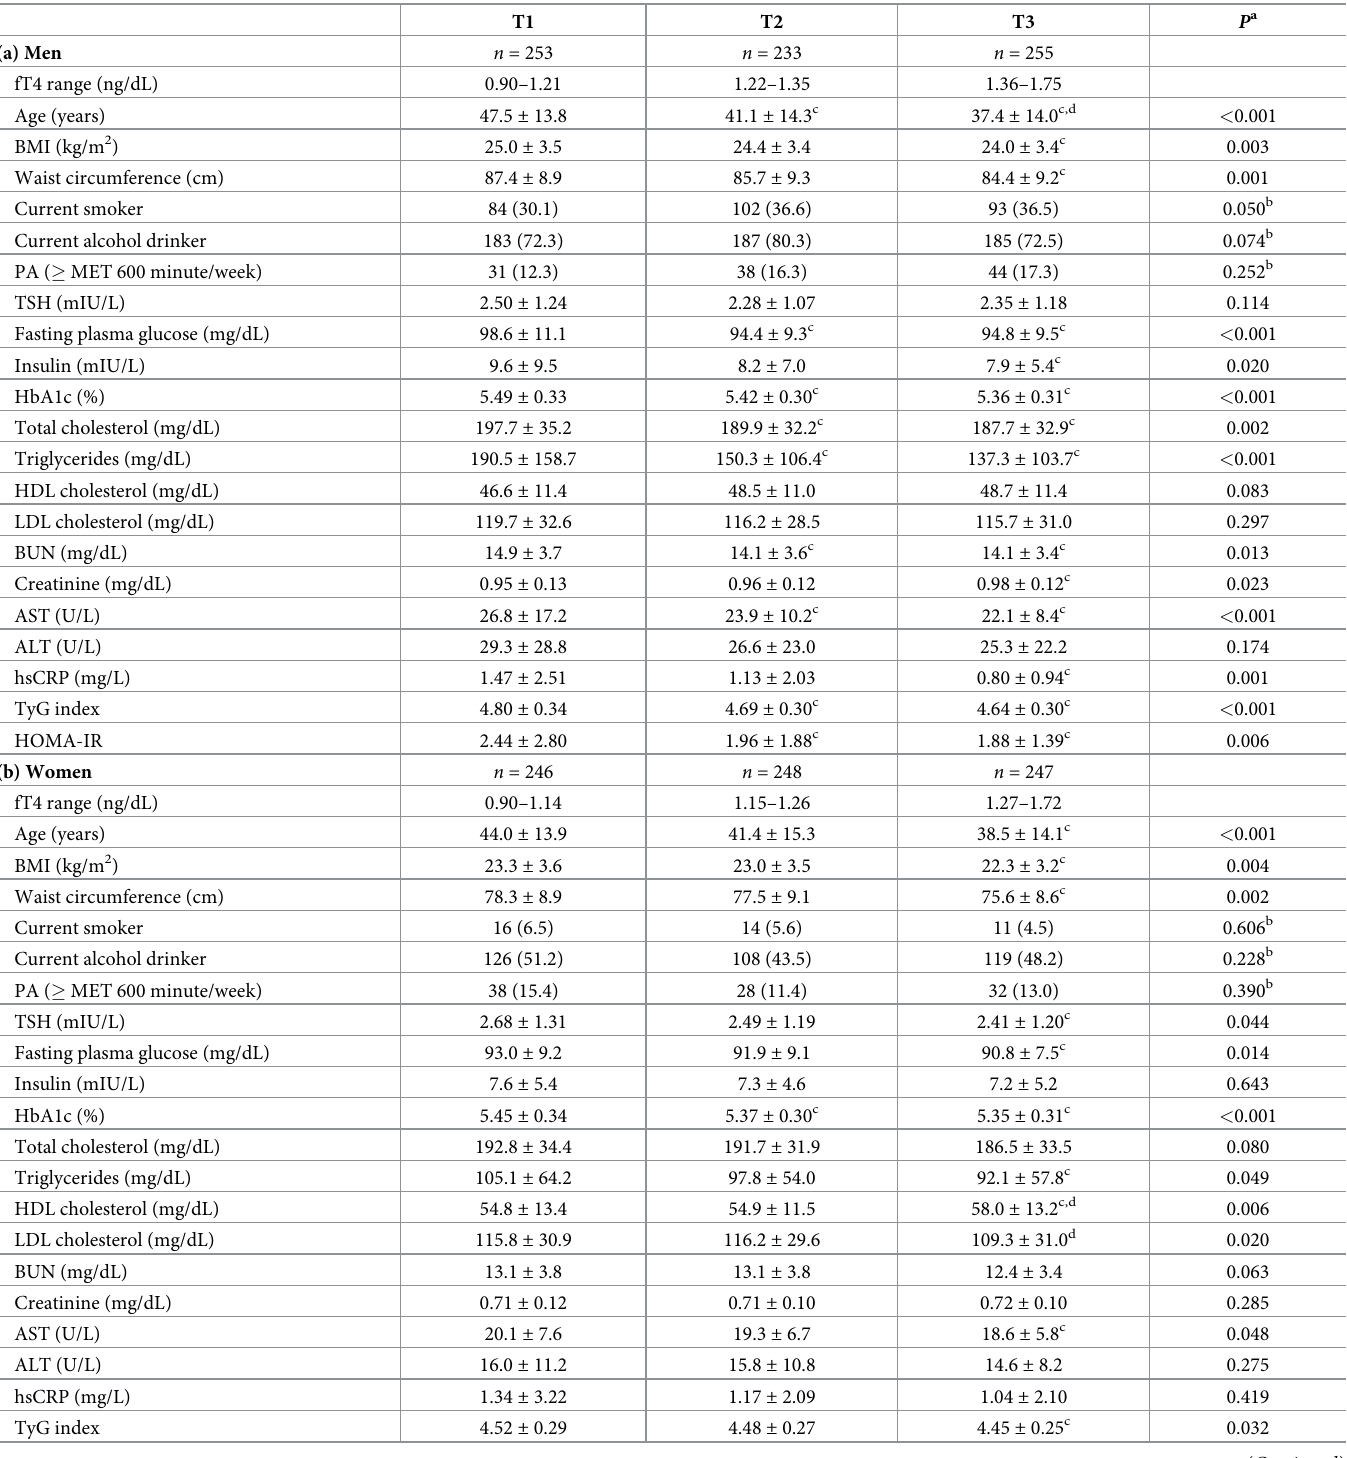
Table 4. Baseline characteristics according to fT4 tertiles by